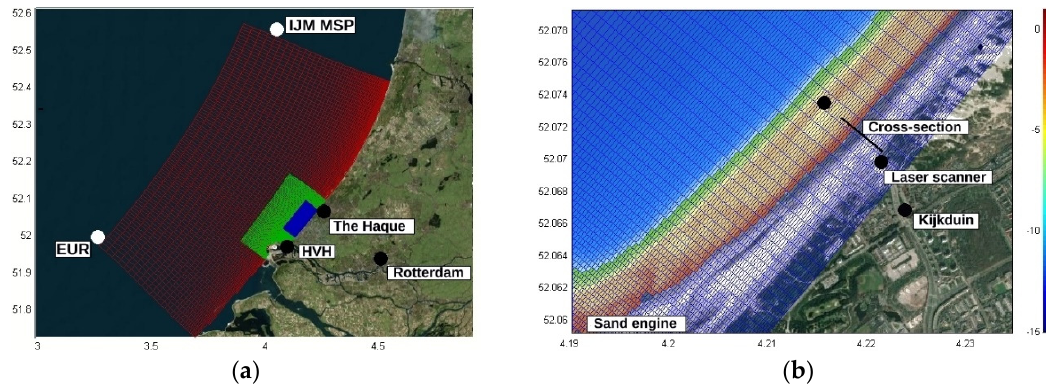
Figure 5 . ( a ) Nested grids used for the calculated wave conditions (coordinates in degrees N and E). Wave boundary conditions were provided by the Europlatform (EUR) and IJmuiden Munitie Stortplaats (IJM MSP) wave buoys and wind data were provided at Hoek van Holland (HVH); ( b ) Local wave grid near Kijkduin with water depth indicated in color (red (0 m NAP) to blue ( − 10 m NAP.) and with the wave output point at − 3 m NAP. relative to the analyzed cross-section and the laser scanner.